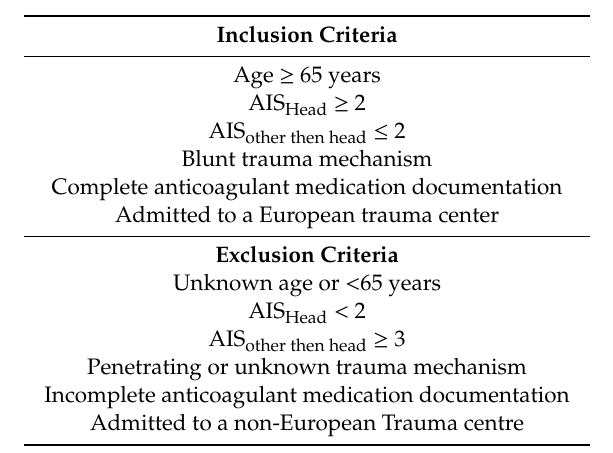
Table 1. Detailed inclusion and exclusion